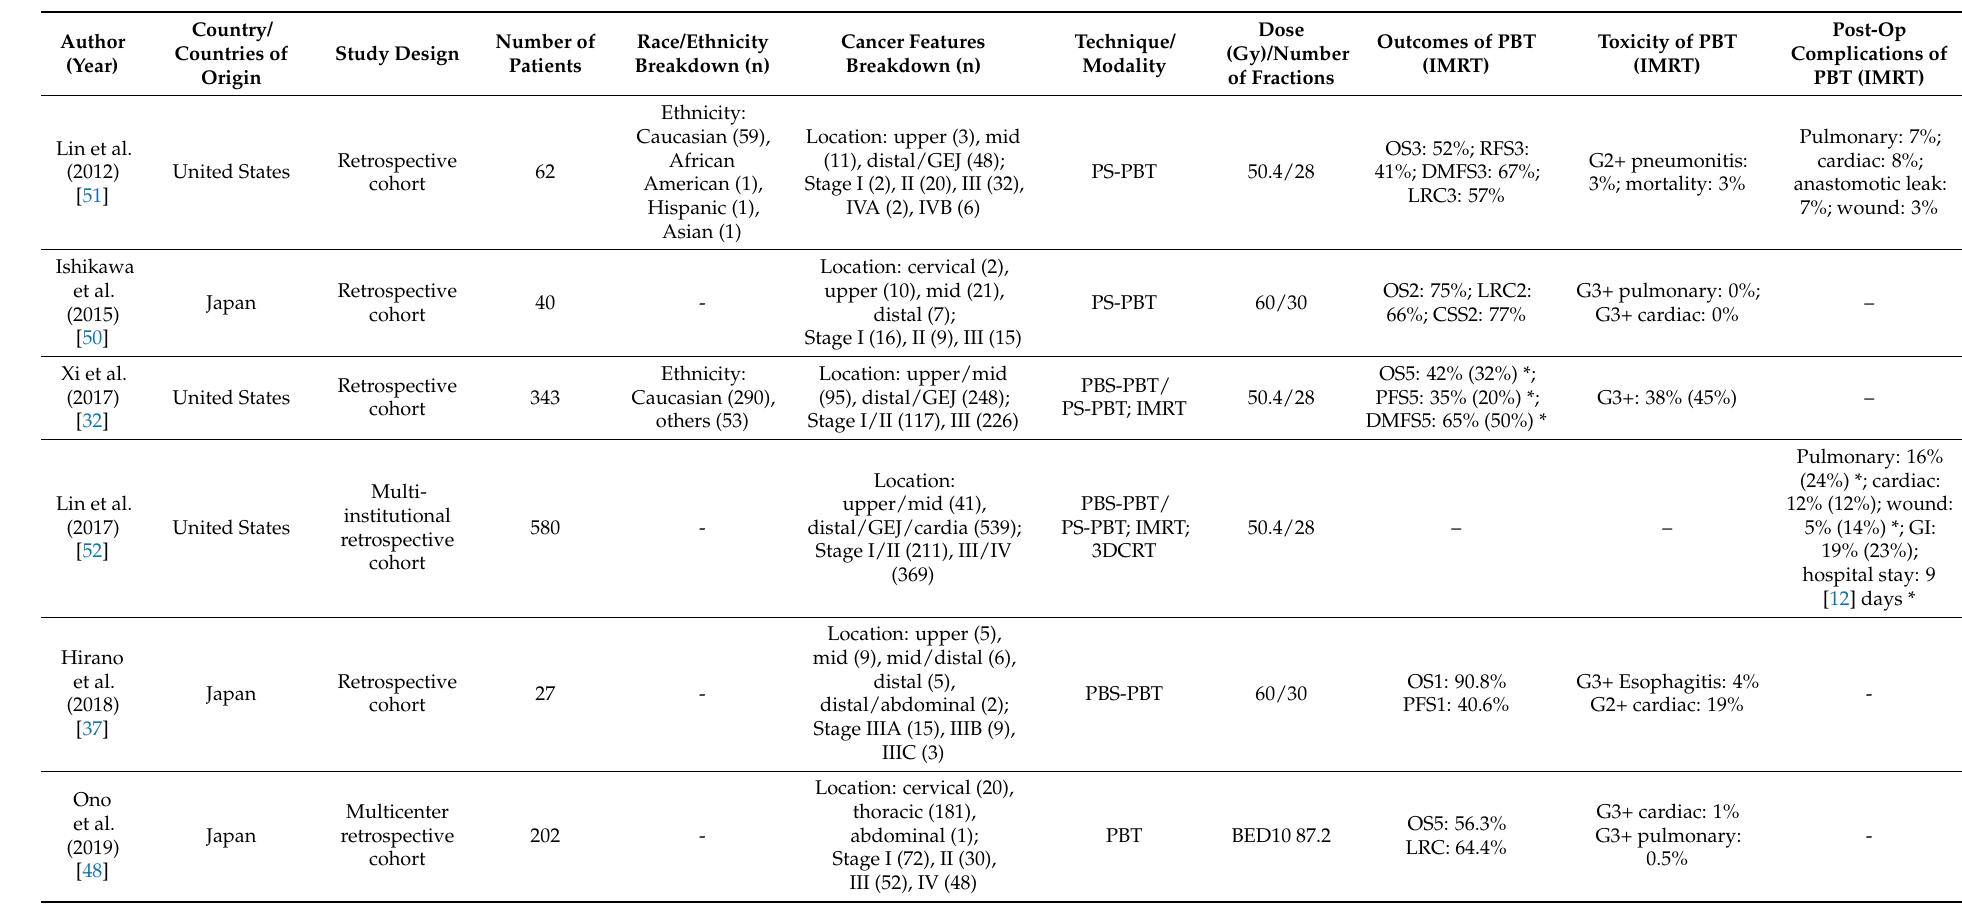
Table 2. Clinical studies comparing PBT vs. IMRT for esophageal cancer treatment. This table builds upon studies reviewed in Jethwa et al. (2020)